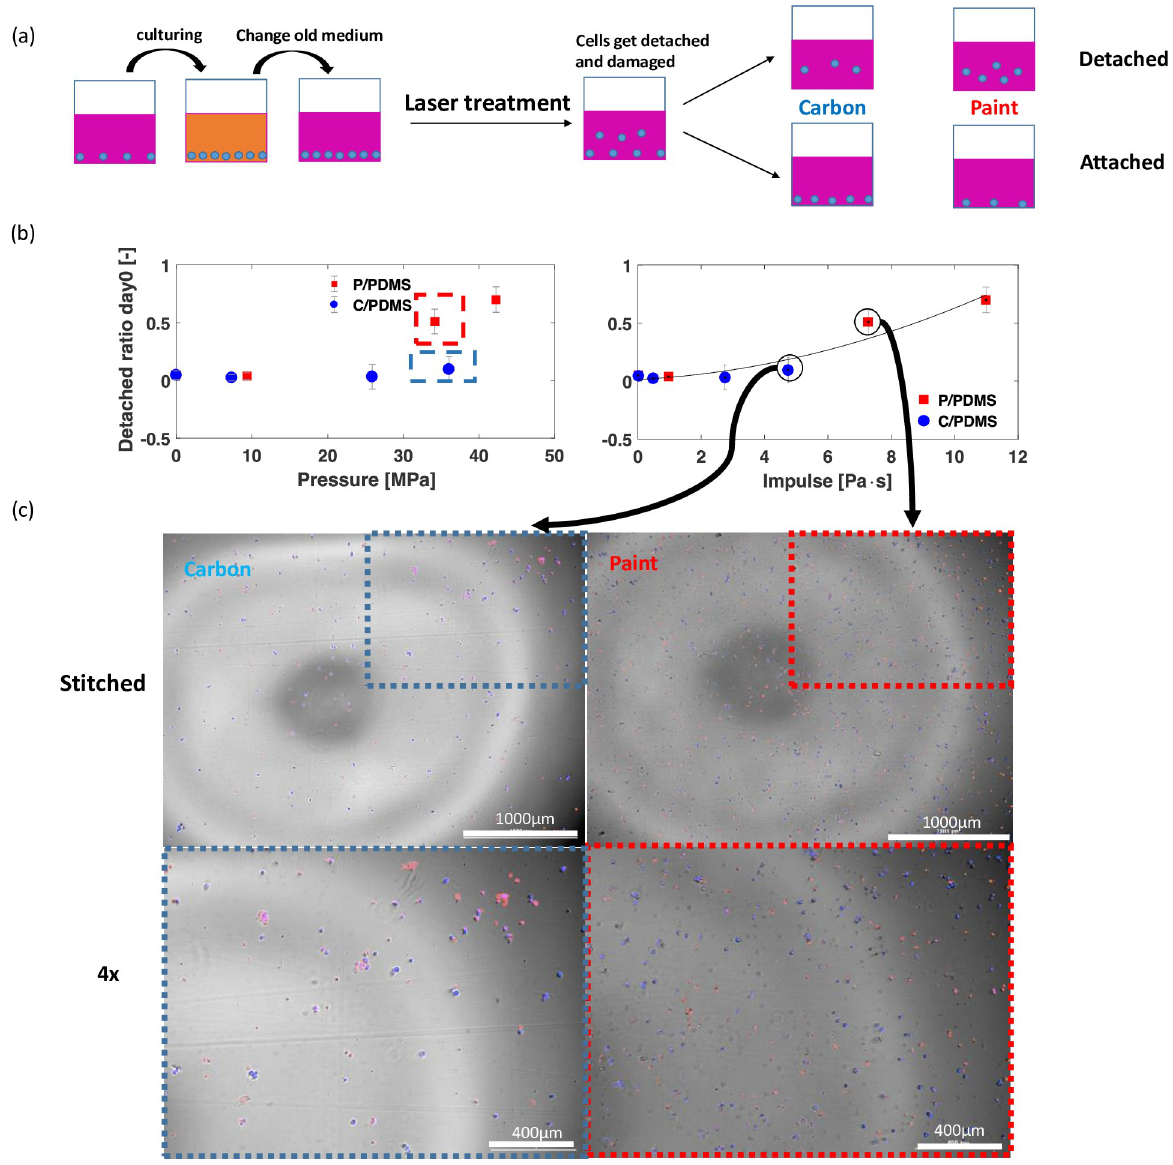
Fig 6. (a) Workflow for the imaging tests. The pink color represents the fresh medium while the maize color represents the old medium. The blue dots represent cells. (b) Detached cell ratio versus pressure and detached cell ratio versus impulse from imaging results for both P/PDMS and C/ PDMS coatings. The error bars show the standard deviations. Results are from three independent tests and four samples were tested in each independent test. (c) Sample images from the circled cases are shown. The blue dots in the image represent the total detached cells. The red dots in merged images represent the dead